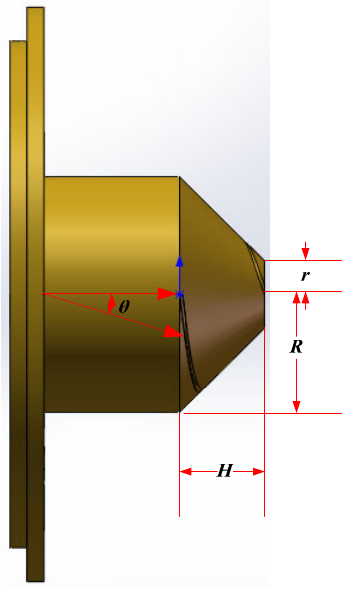
Fig. 3 Rotation transfer